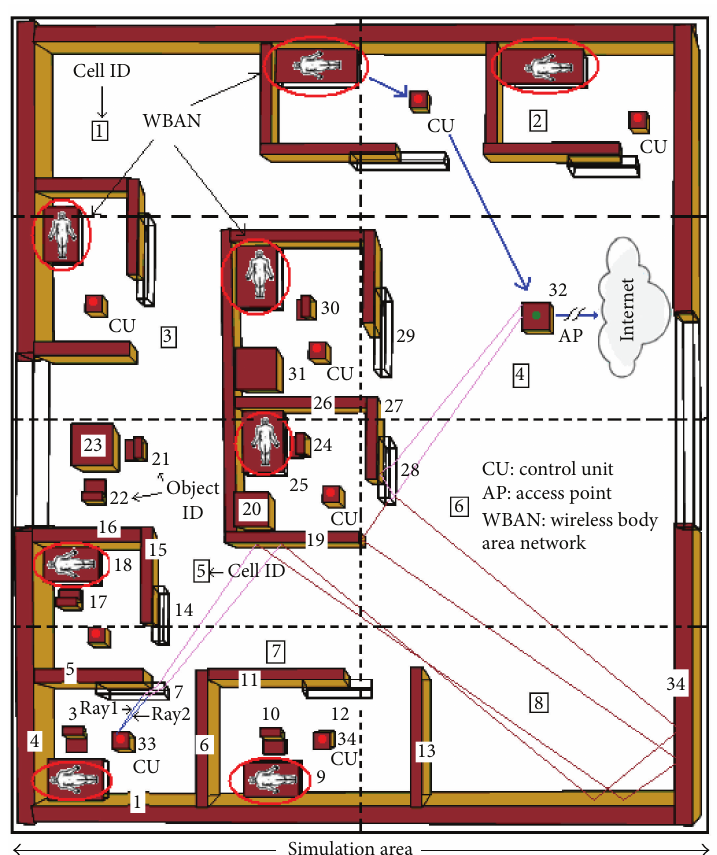
Figure 11: Ray tracing procedure of the proposed